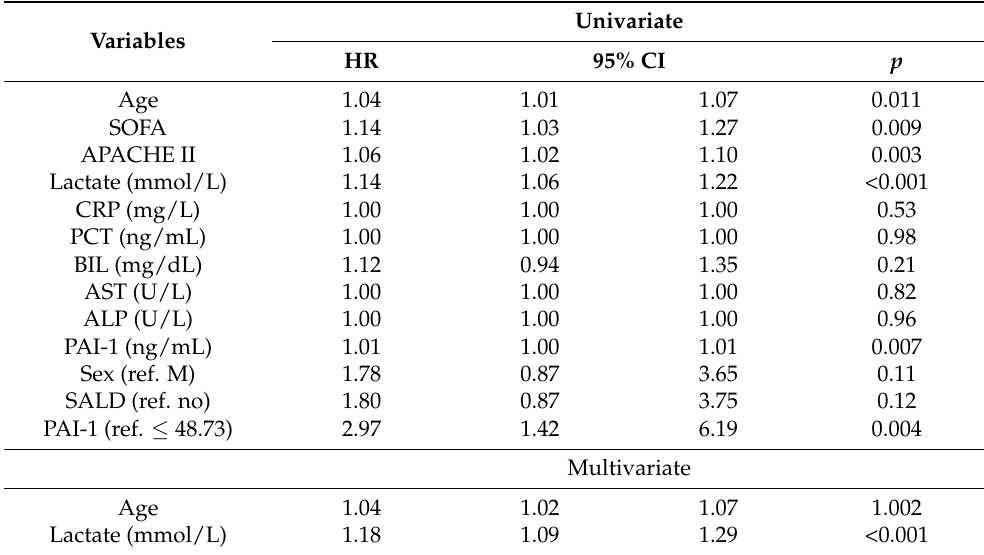
Table 6. Univariate and multivariate Cox regression analysis of risk factors influence on